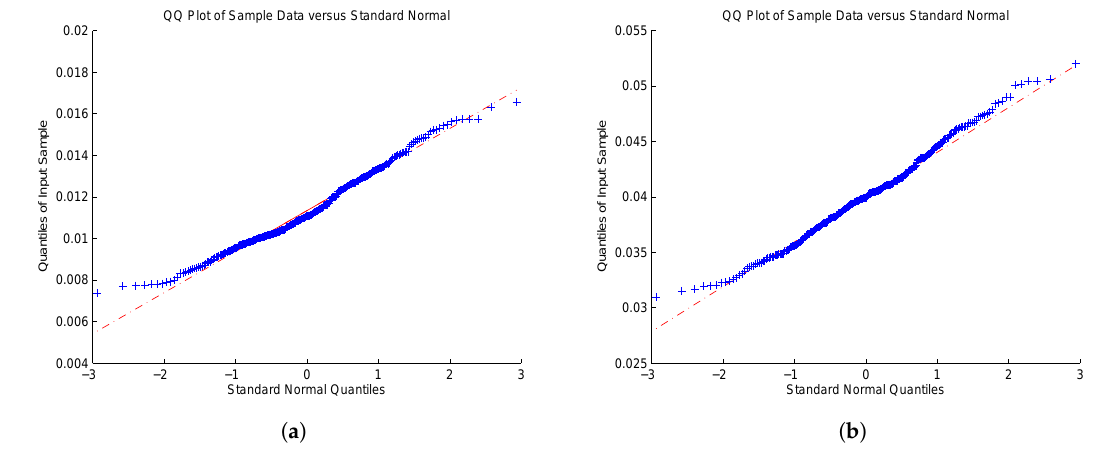
Figure 6. QQ-plot of (cid:98) φ K ( 5 ) for (GS); ( a ) T n = 120, and ( b ) T n =